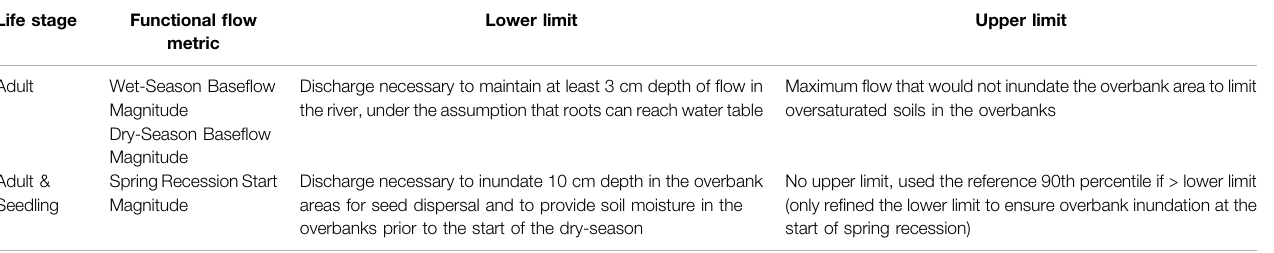
TABLE 1 | Habitat criteria used to determine ecological fl ow needs for willow adult and